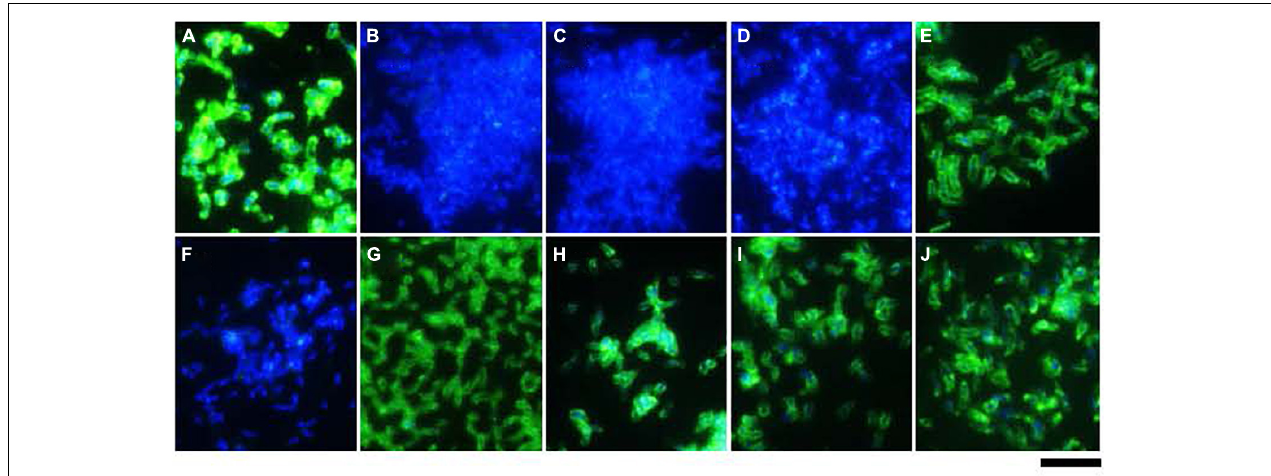
FIGURE 4 | Surface expression of BadA in various B. henselae strains (immunofluorescence microscopy). Surface expression of BadA was analysed via immunofluorescence microscopy using specific anti-BadA IgG antibodies (green). Bacterial DNA was counterstained using DAPI (blue). The illustrated B. henselae strains are (A) Marseille, (B) Marseille (cid:49) BadA-T, (C) Marseille (cid:49) BadA-D, (D) ATCC49882 T var-1, (E) ATCC49882 T var-2, (F) Berlin-I, (G) G-5436, (H) 88-64 Oklahoma, (I) FR96/BK38, and (J) FR96/BK3. Expression is observed for strains Marseille, ATCC49882 T var-2, G-5436, 88-64 Oklahoma, FR96/BK38, and FR96/BK3, detected by the characteristic green halo. Strains ATCC49882 T var-1 and Berlin-I do not express BadA, nor do the negative control strains Marseille (cid:49) BadA-T and Marseille (cid:49) BadA-D. Scale bar: 5 µ m.